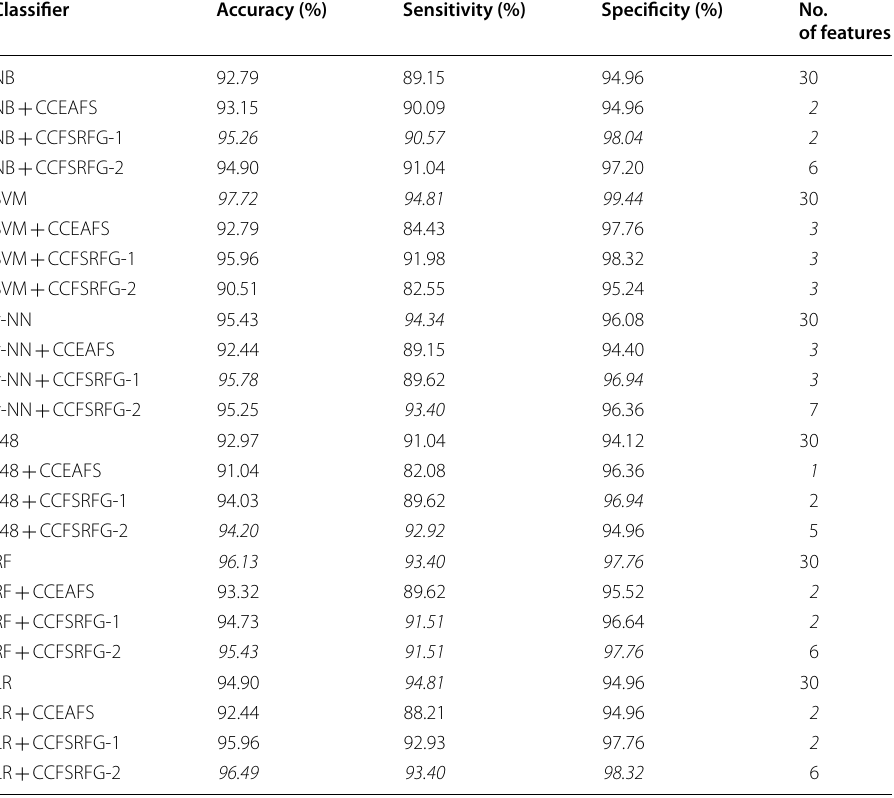
Italic signifies the improvements of the proposed approach over existing